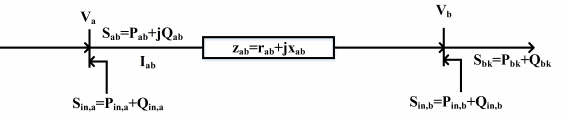
Fig. 1. Branch power flow model of distribution